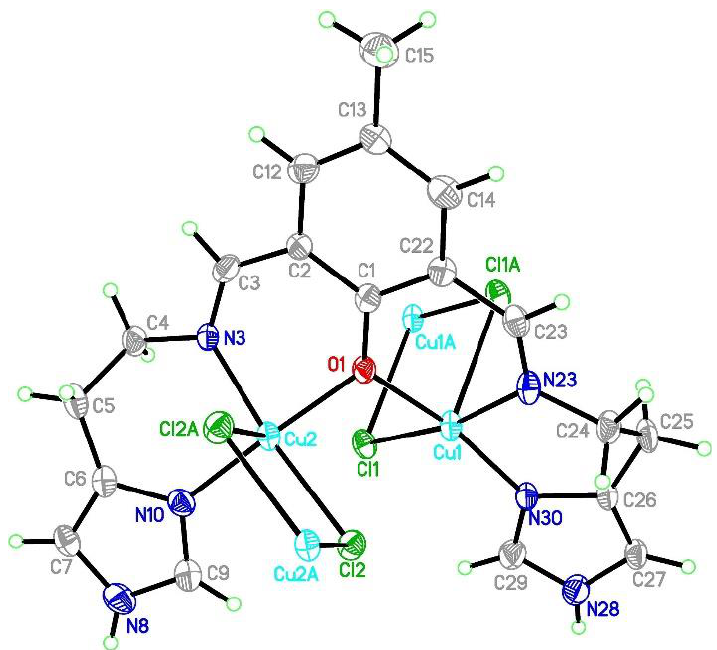
Figure 3. Asymmetric unit of the crystal structure of {[Cu 2 (L1)Cl 2 ] 2 [CuCl 4 ]} · 2MeCN · 2H 2 O ( 1 ). Ellipsoids are plotted at 30% probability level.